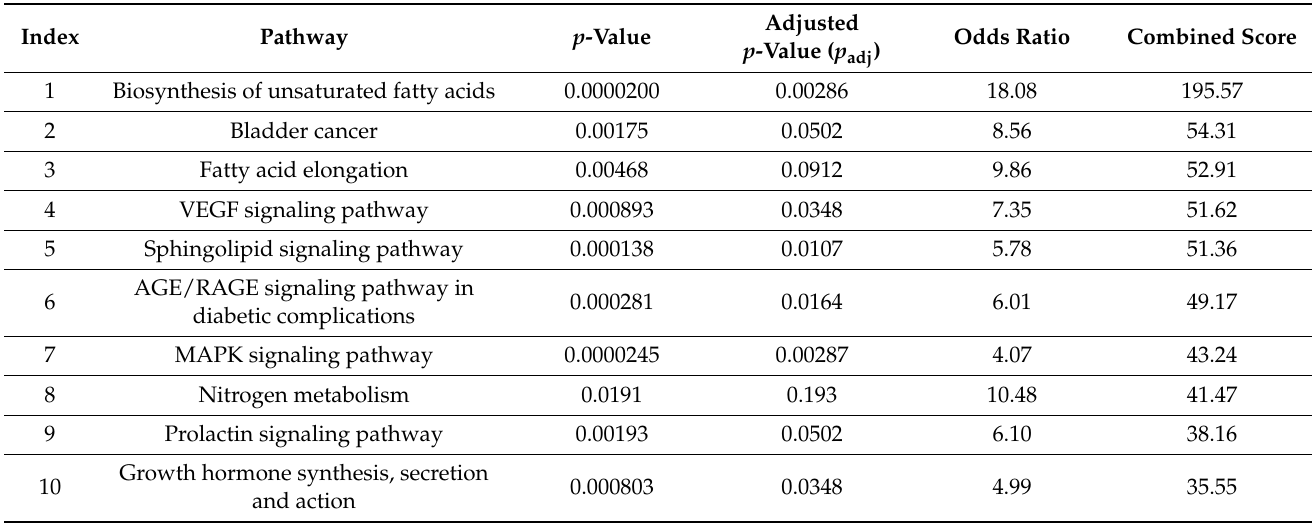
Table 1. The top overrepresented pathways identified through impact analysis of differentially expressed genes (DEGs) when comparing the sensitive and non-sensitive colorectal cancer (CRC) cell